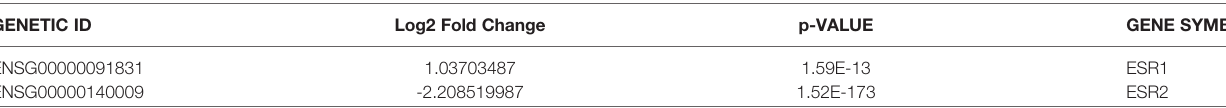
TABLE 2 | The Expression of ERs Relative Genes. GENETIC ID